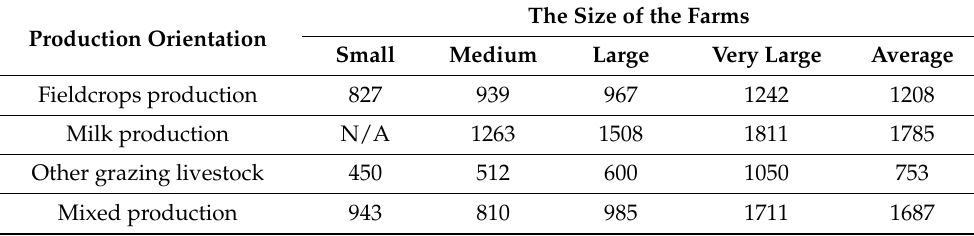
Table 6. Land productivity (2015–2020 average); (EUR/ha).